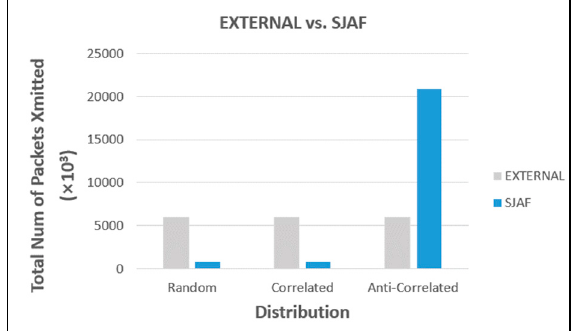
Figure 11. Comparison between EXTERNAL and SJAF.